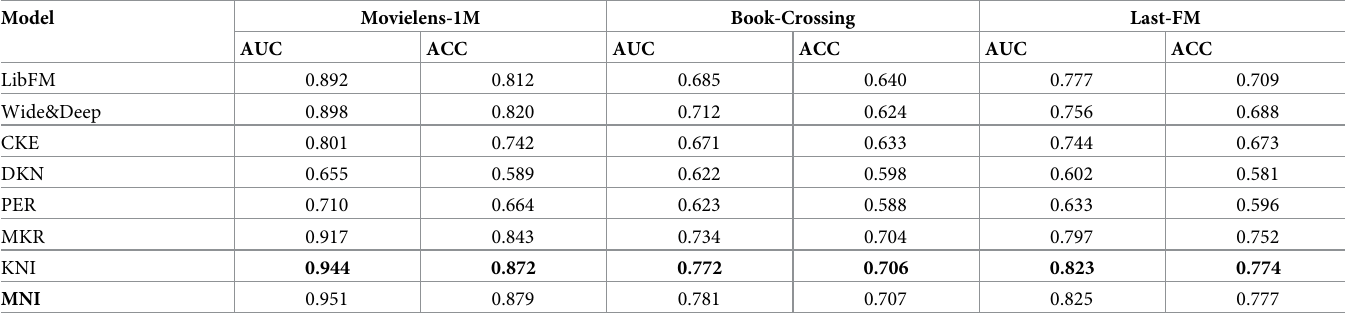
Table 2. Comparison results of AUC, ACC. The result of LibFM, Wide&Deep, CKE, PER, DKN is taken from [23]. Model